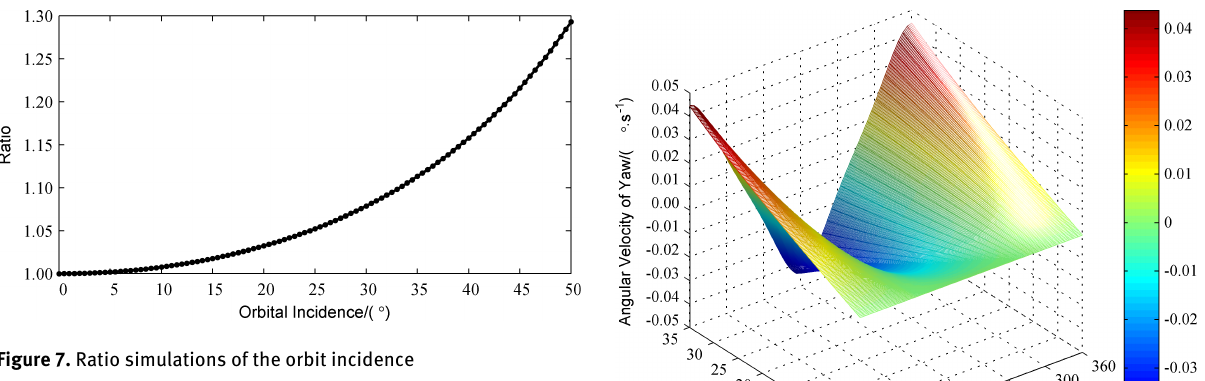
It is assumed that the time when the satellite is at point A is t 0 equaling 0, and the orbital angular velocity of the satellites is ω o . When the satellite arrives at point B at the time t , the orbital phase φ is: